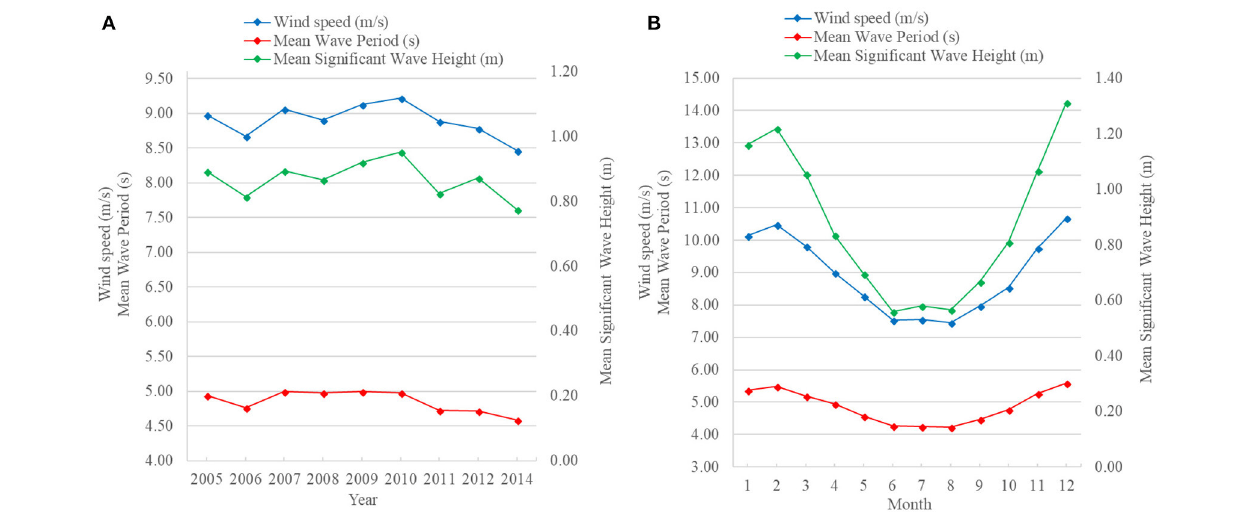
FIGURE 5 | (A) Inter-annual and (B) monthly variability in wind and wave patterns.